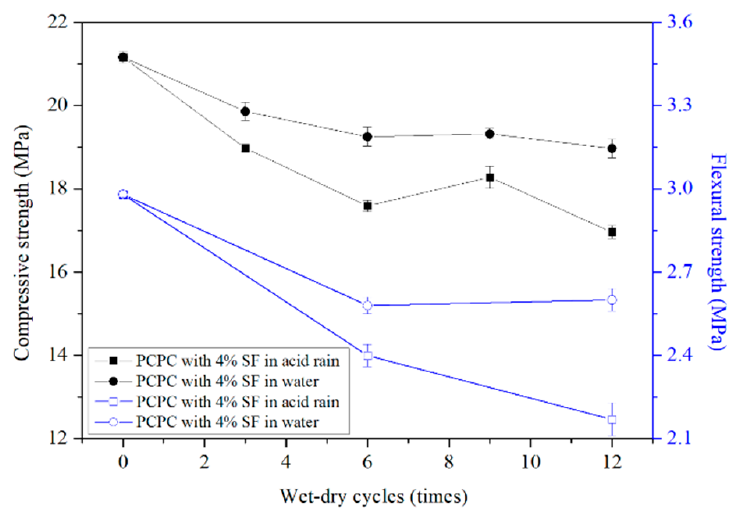
Figure 4. Strength of 4% SF PCPC. Among the cement hydration products, the calcium hydroxide is the most easily corroded by the acid solution. The reaction between SF and Ca(OH) 2 increases the content of C–S–H and decreases the content of the Ca(OH) 2 [39,40]. In addition, the hydration of SF (as shown in Equation (7)) could refine the pores of the hardened cement paste, which is more difficult for hydrogen ions to penetrate into the hardened cement paste. These two actions of SF ultimately improve the acid resistance of PCPC [45,46].